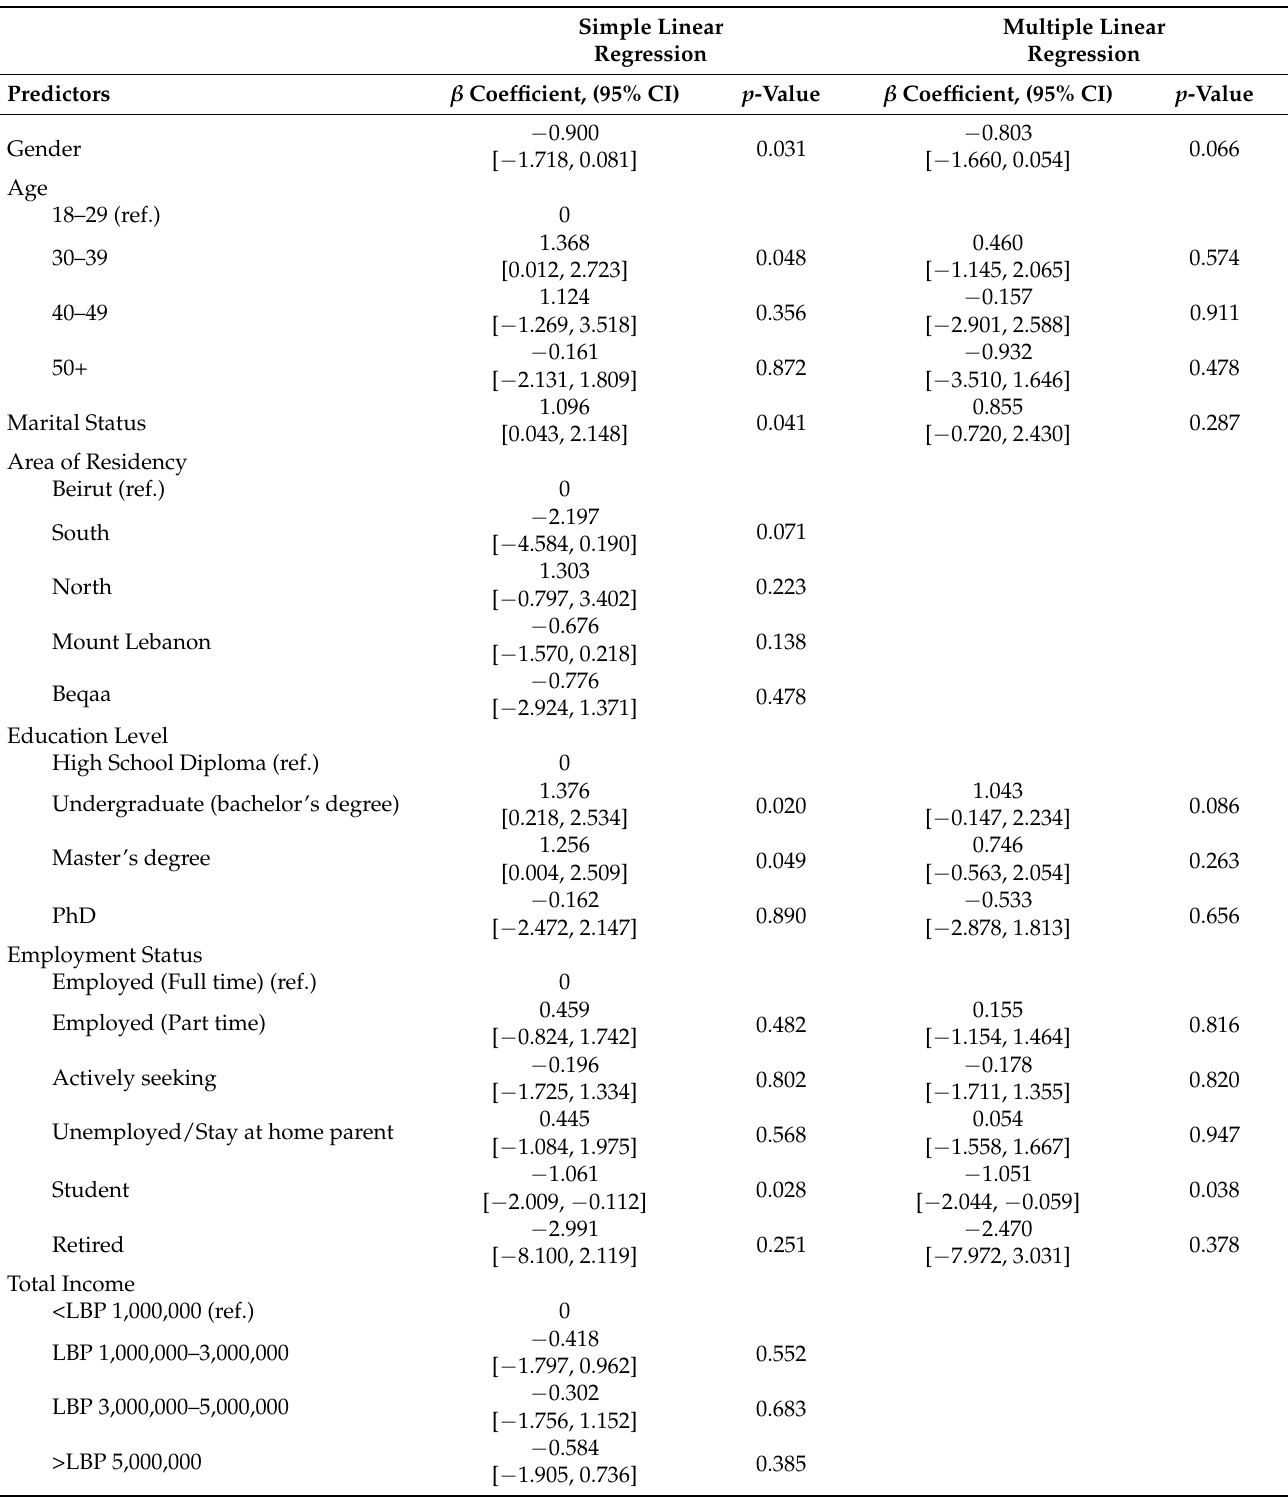
Table 3. Simple and multiple linear regression analyses for the association of characteristics of study participants with the knowledge